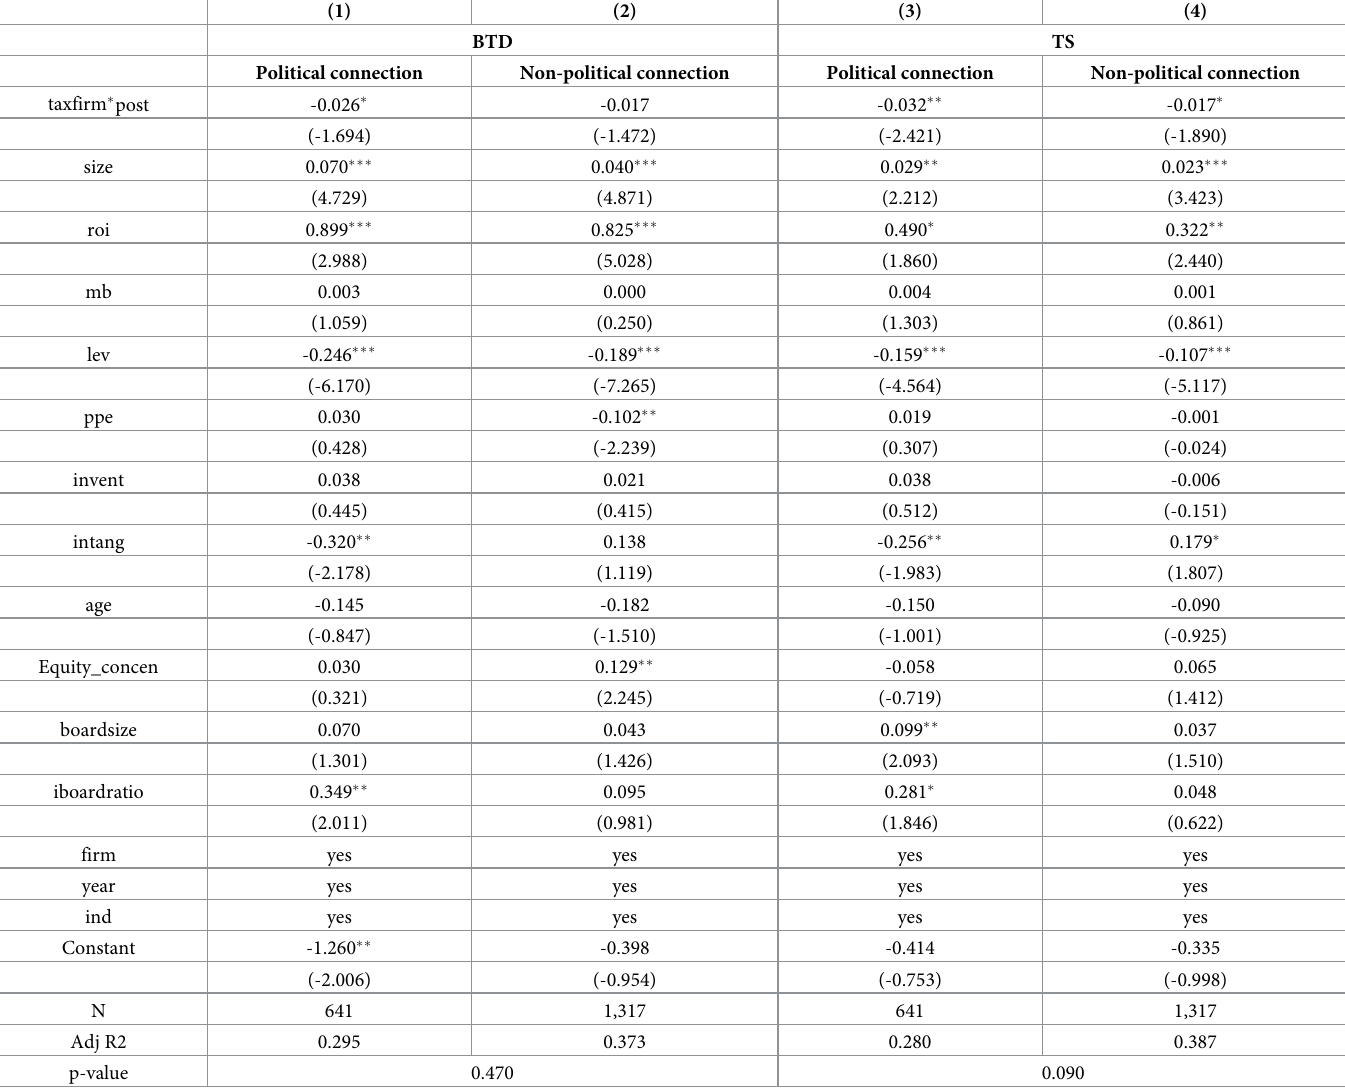
Table 14. The impact of political